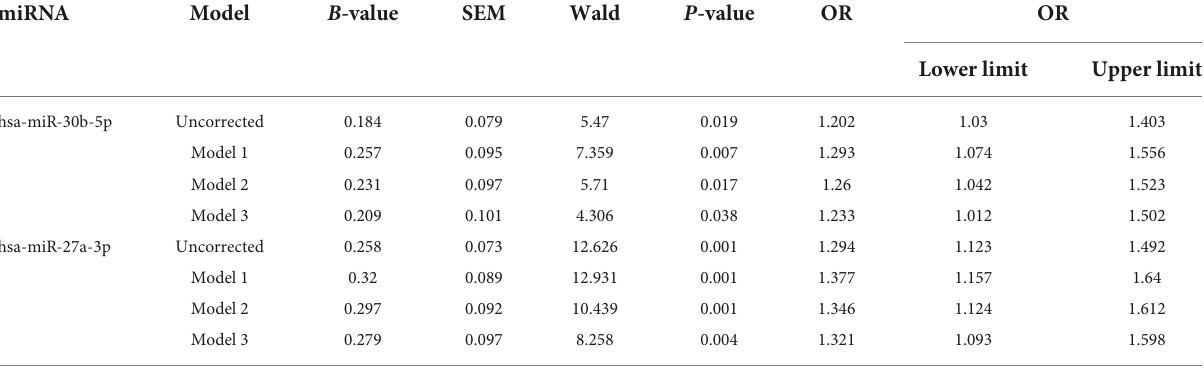
Lower limit Upper limit